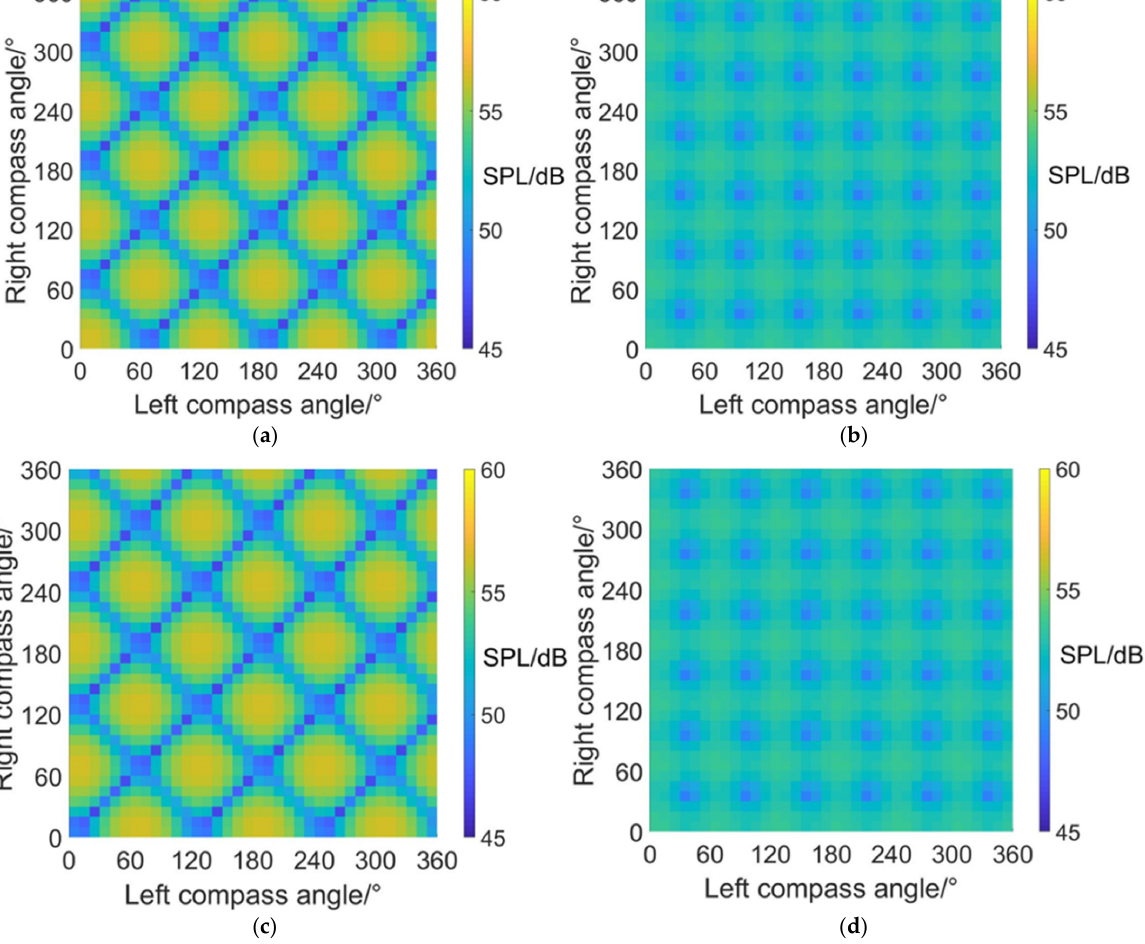
Figure 11. Carpet diagrams of noise SPL in helicopter mode at an azimuth angle = 90° with a scissors angle difference = ( a ) 0°, ( b ) 30°, ( c ) 60°, ( d ) 90°.